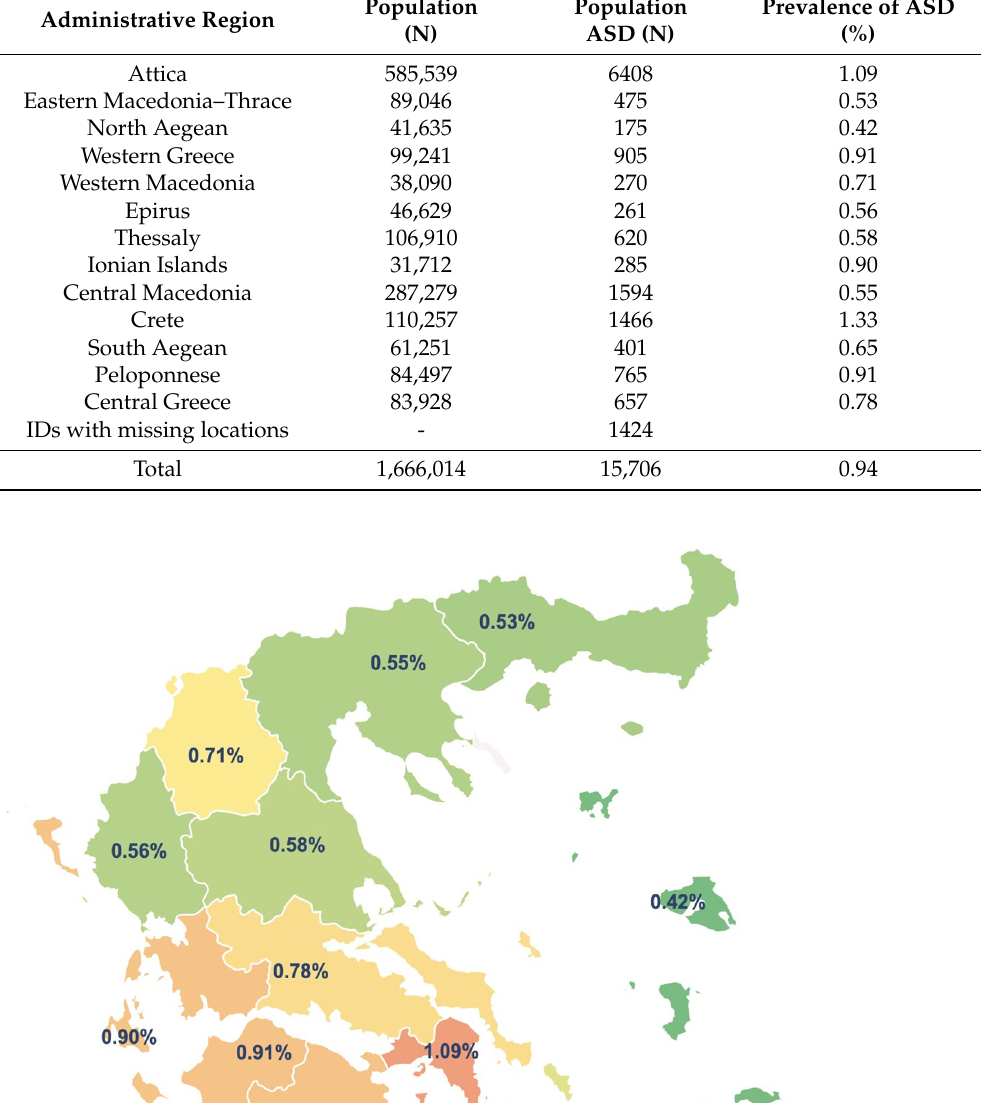
Table 2. The prevalence of ASD in Greece in 2021 for children aged 2–17 years.